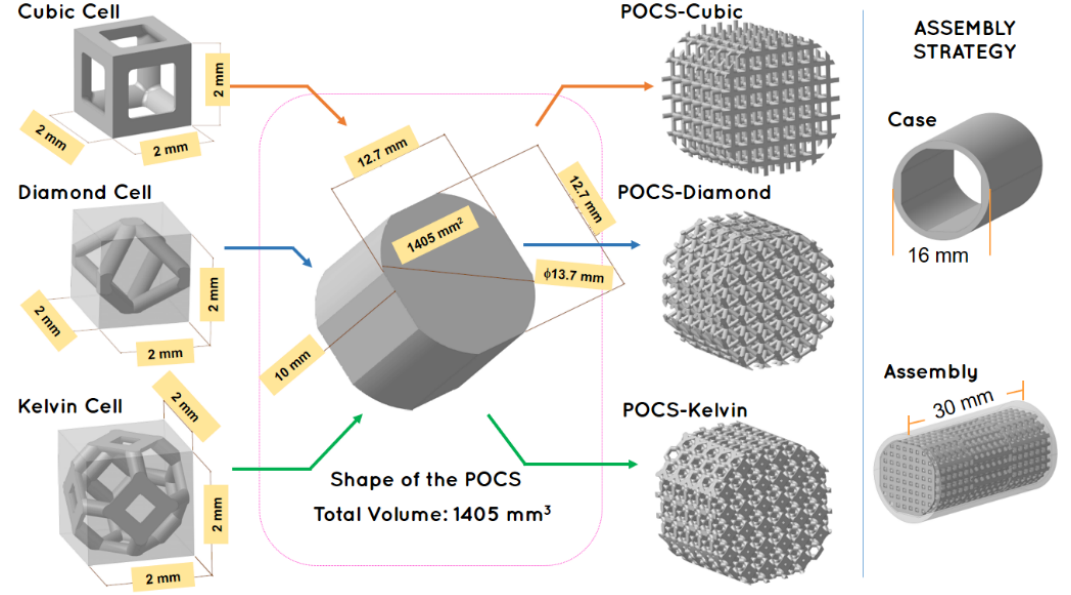
Figure 13. Design elements of the POCS including the main geometry (projected squircle) that is common for the three unit cells that were projected in final structures.